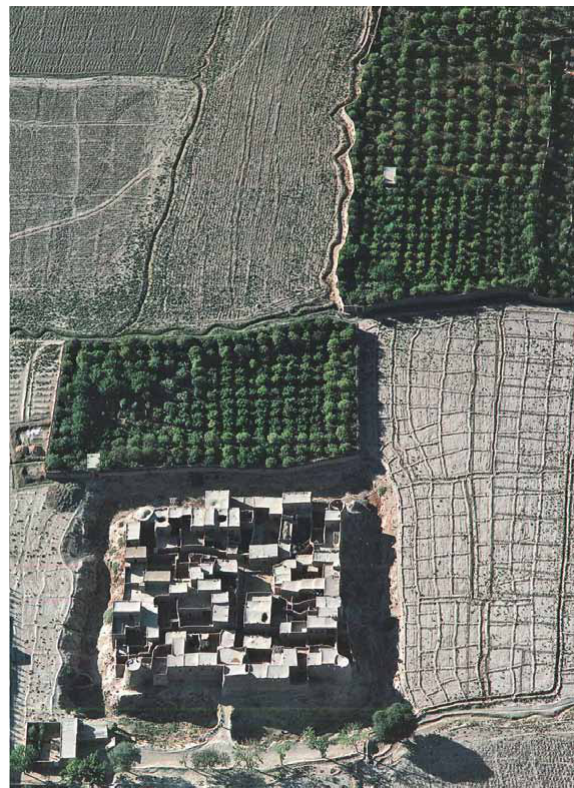
fig. 9. Garden as the Index of the City. a village near neyriz. Source : Mousavi, a; Stronach, D. 2012. ancient Iran from the air. Mainz: Verlag Philipp von